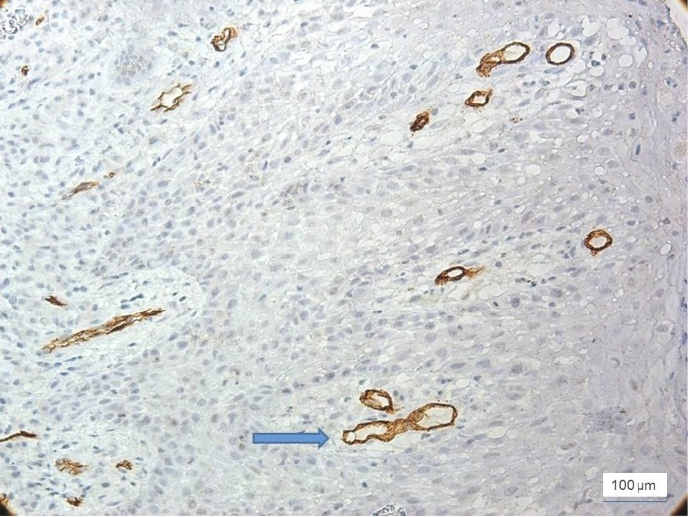
Figure 4. Large dilated and branched vessels, anti-CD34 immunohistochemical staining, and DAB chromogen, ×200 magnification.